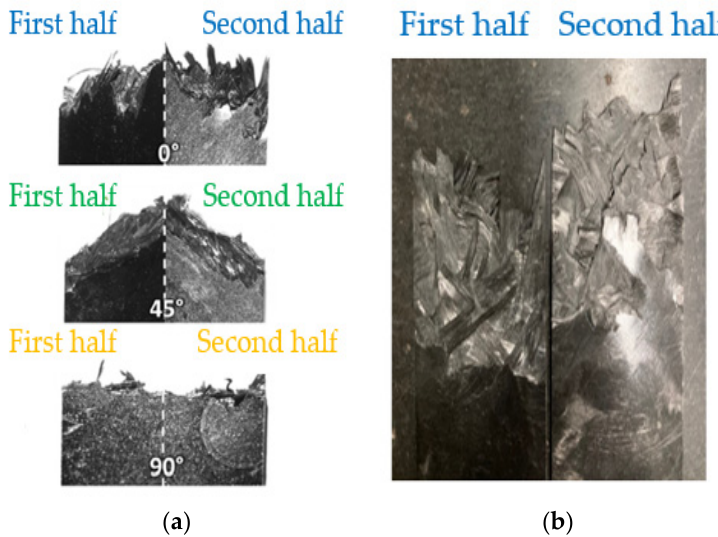
Figure 21. Fracture trends: ( a ) the results of Martulli et al.’s study [27] and ( b ) the results of this study.